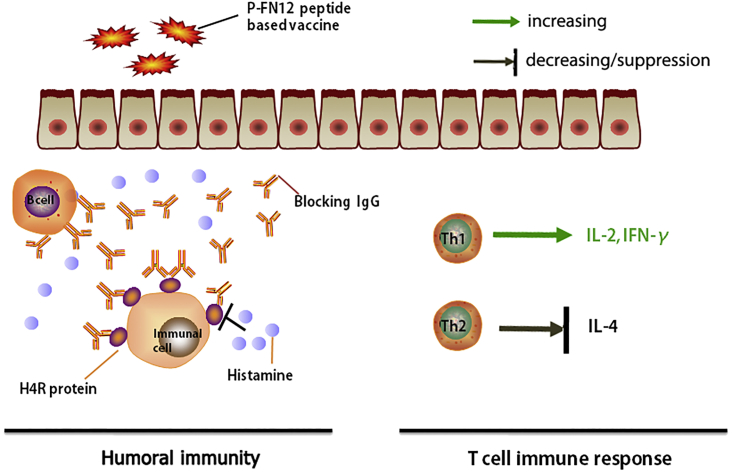
Graphical Depiction of the Immunological Effects of the Formulated P-FN12 Peptide-Containing Vaccine on Immediate Reactions and the Elicited T Cell Immune ResponseVaccination induced protective blocking by IgG antibodies. These allergen-specific antibodies thus prevented the binding of histamine to the H4R protein. Another approach can be used to establish an appropriate allergen-specific Th1/Th2 ratio, with the goal of correcting the immune disorder.